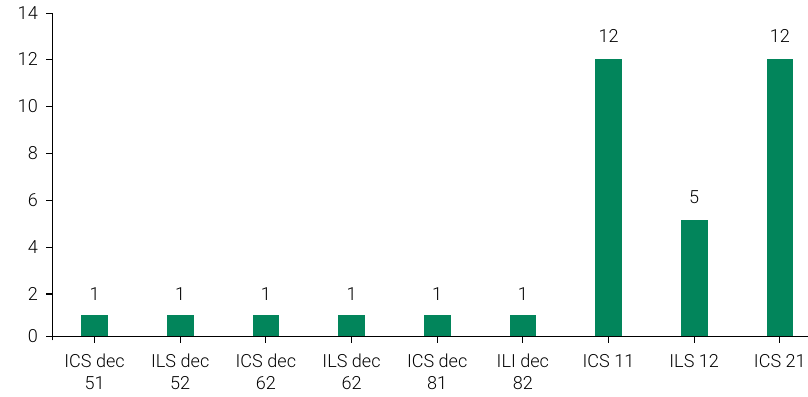
Figure 1. Distribution of affected teeth and their respective